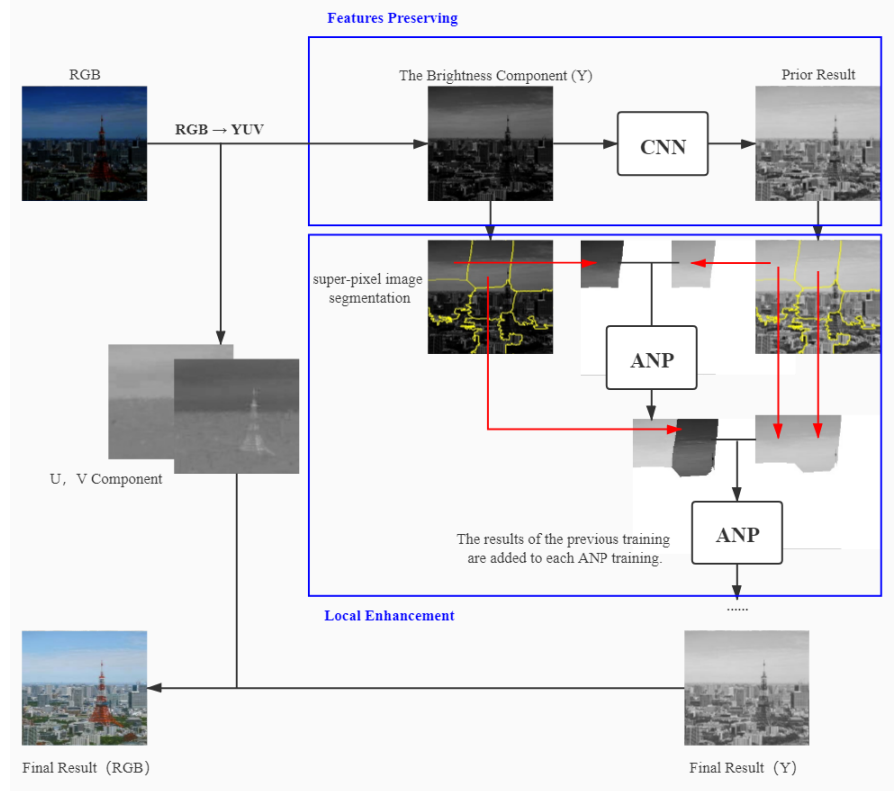
Figure 2. The flowchart of our method.